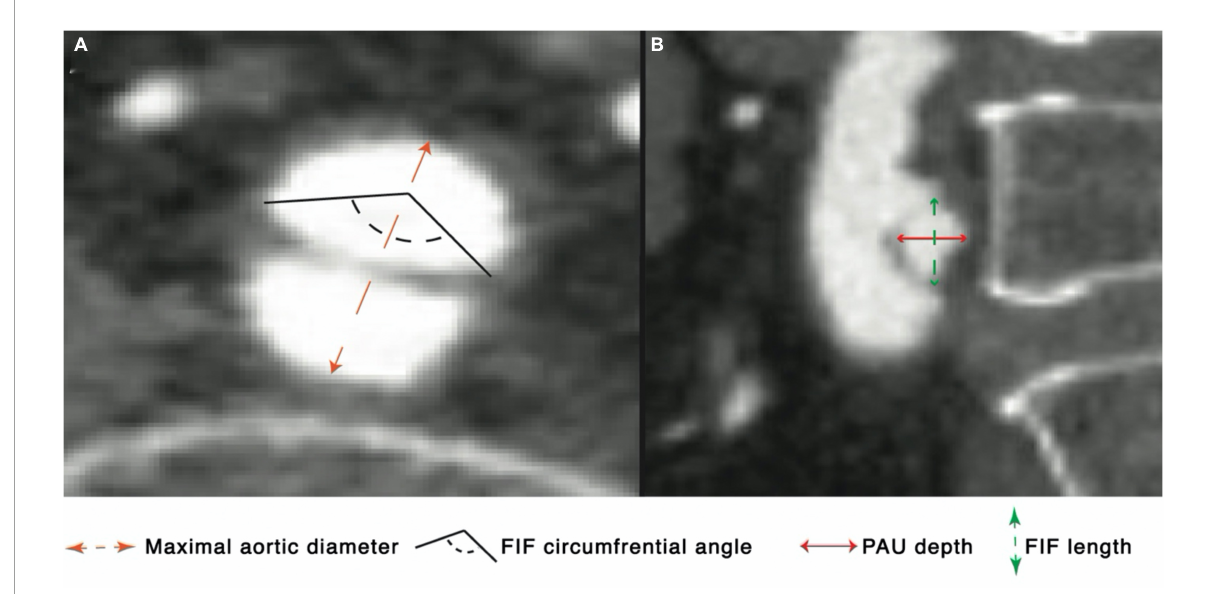
FIGURE1 Diagram depicting measurements performed on axial (A) and longitudinal (B) plane using CTA in a patient with a PAU-like focal intimal flaps